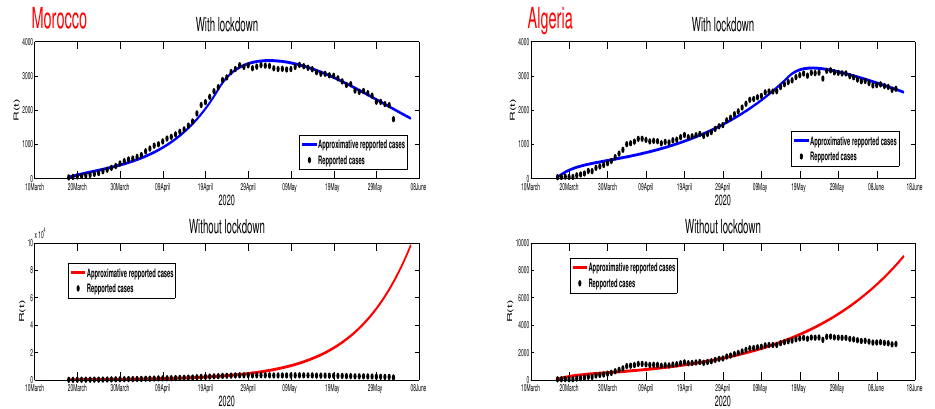
Figure 8. The time series of the number of reported infected cases with and without the lockdown, where it shows the importance of the lockdown in reducing the burden of the epidemic in Morocco and